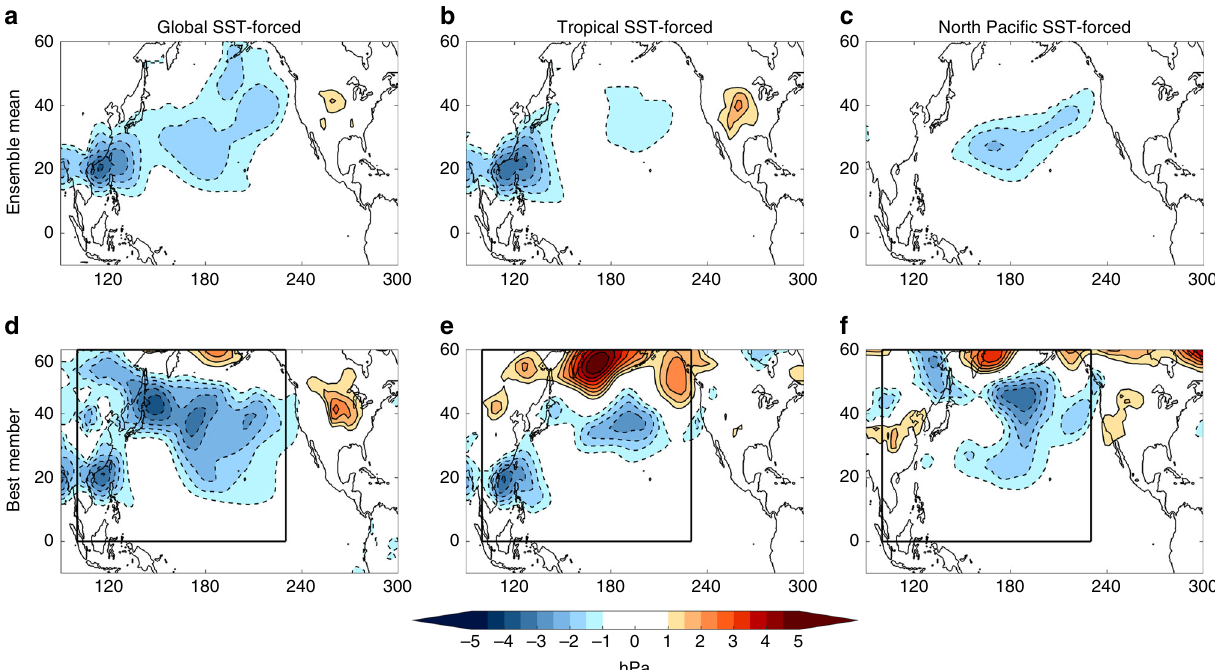
Fig. 5 Simulated sea level pressure anomalies for summer 2019. a – c Ensemble mean June – August (JJA) 2019 sea level pressure anomalies (SLPAs; hPa; shading) for the Global, Tropical, and North Paci fi c sea surface temperature forced experiments, respectively. d – f Single Best Member match for each ensemble of simulations based on pattern correlation of model and atmospheric reanalysis SLPAs in black box (see Fig. 2). Simulated anomalies shown are signi fi cant at 95% for a Student ’ s t